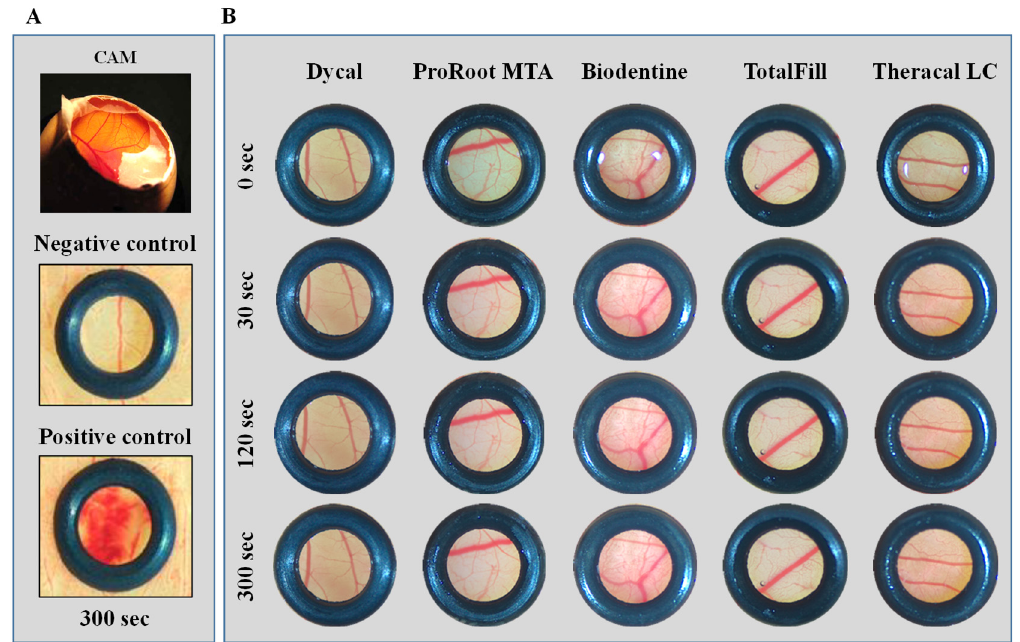
Figure 2. ( A ) Viable counts of the sessile S. mutans population after a 24 h direct incubation with the set CSCs, expressed as mean Log 10 CFU/mL. ( B ) SEM images of S. mutans morphology on the surface of the materials (scale bar 2 µm). * Statistically significant difference from the control, p ≤ 0.05.